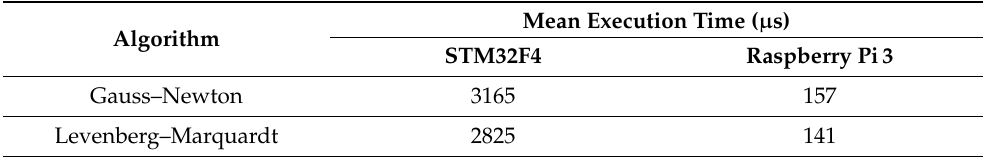
Table 5. Mean execution time of the Gauss–Newton and Levenberg–Marquardt methods (per iteration) using sinusoidal